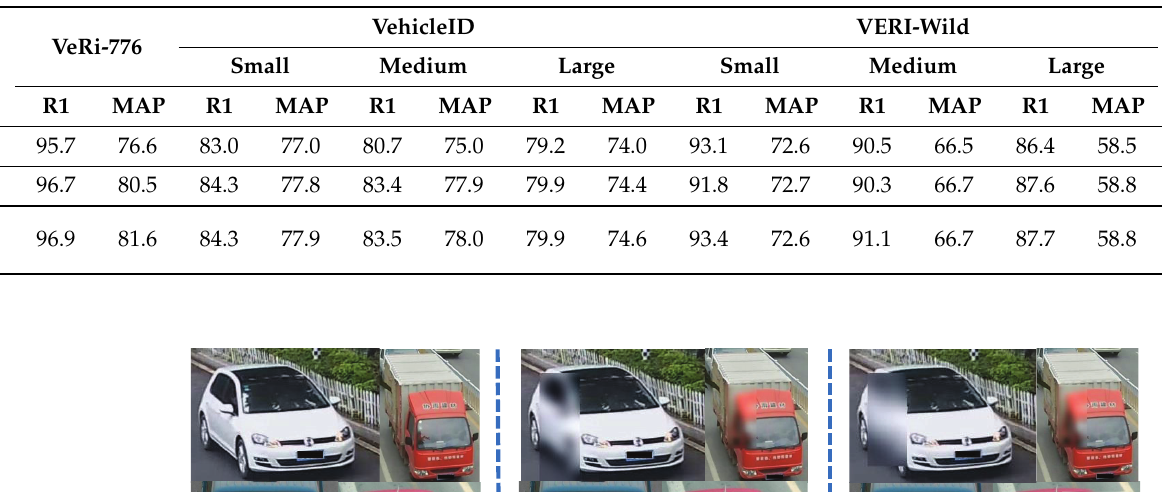
Table 2. Results on the three datasets (%).